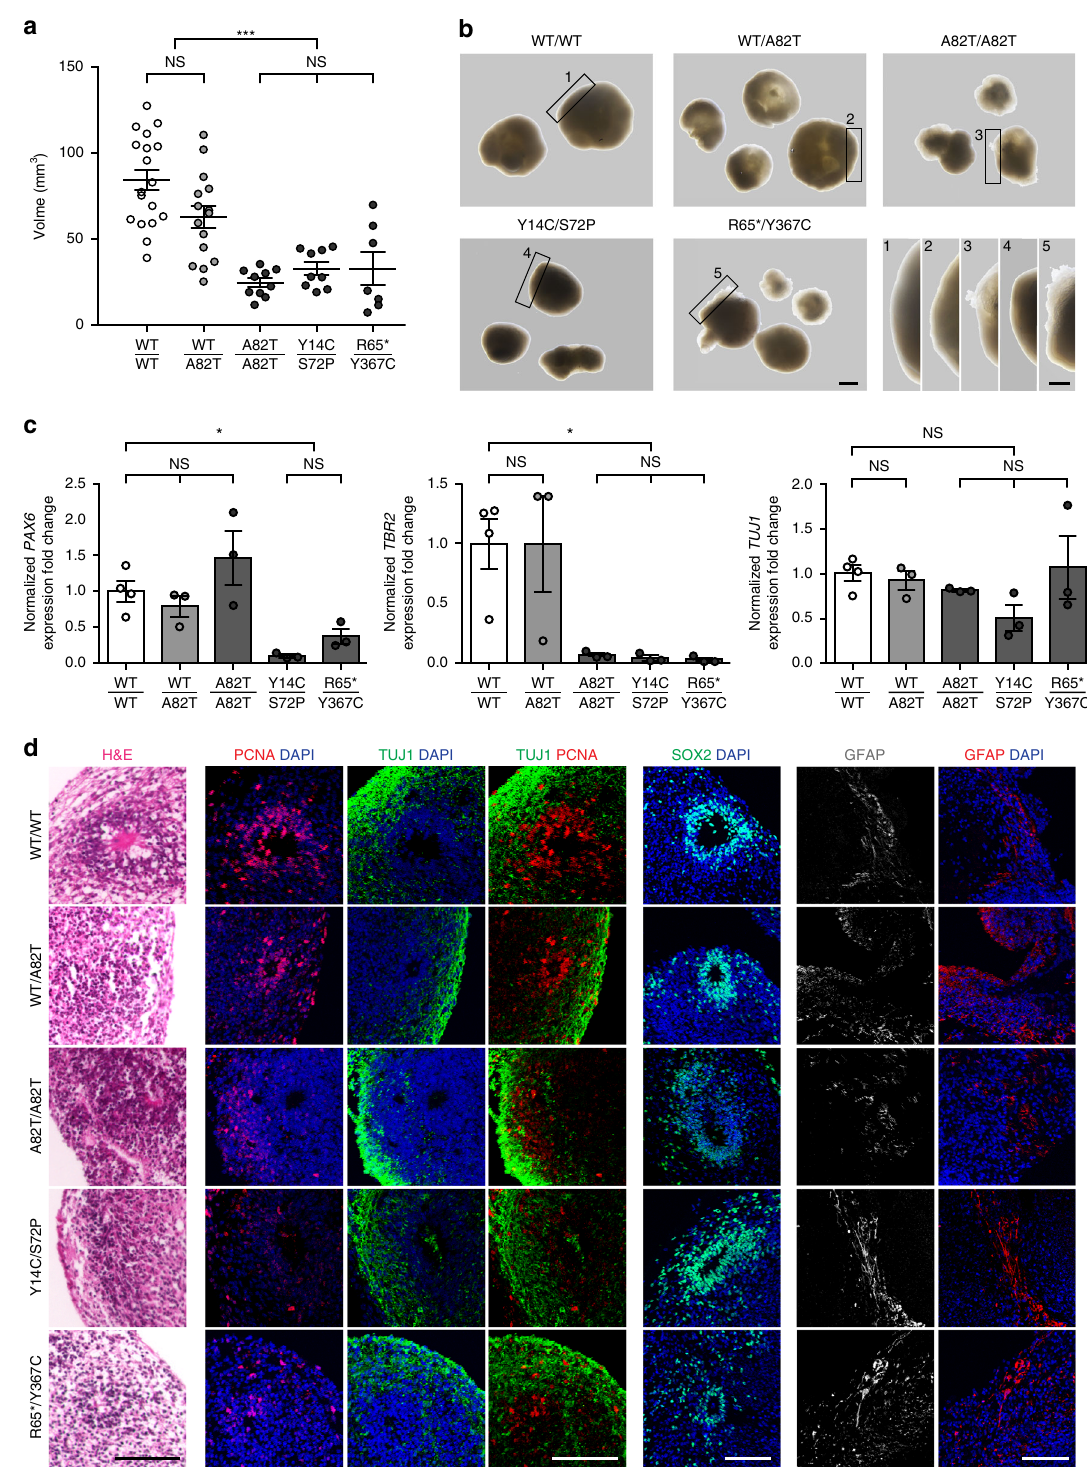
Methods Ethical approval . Written informed consent was obtained from the parents of the underage patients for diagnostic procedures and next-generation sequencing, as well as for the publication of identifying facial images in Fig. 1b. The study has been approved by the local Institutional Review Board of the Medical Faculty of the University of Tübingen, Germany (vote 180/2010BO1). Exome sequencing . To unravel the molecular cause of the disease exome sequencing were performed at different genetic institutes using next-generation sequencing techniques according to local standard protocols. Variants were